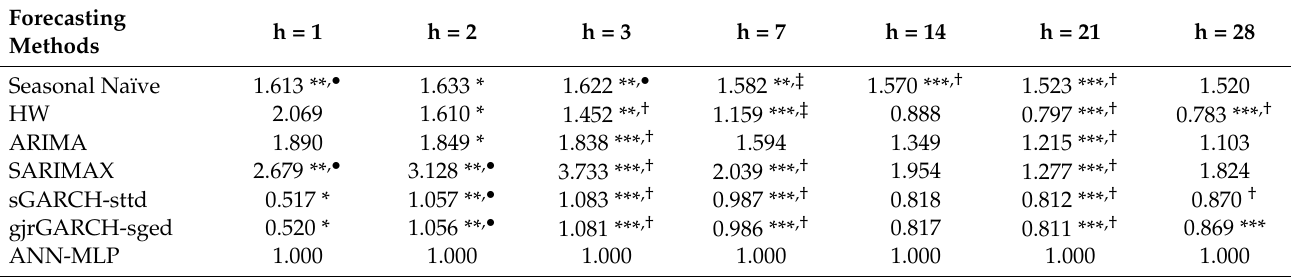
Figure 5. Average rMAPE of forecasting methods. Table 4. Average rRMSE of forecasting